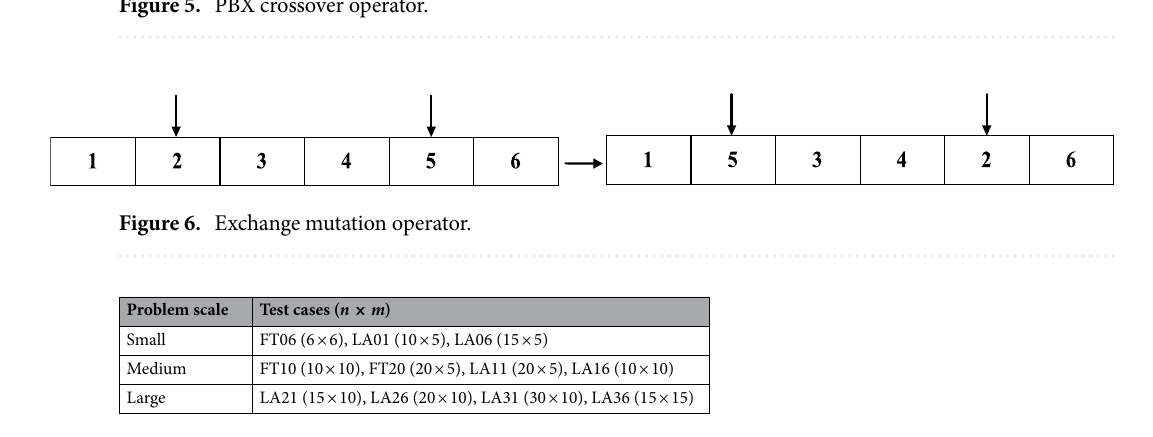
Table 2. Scale division of the test